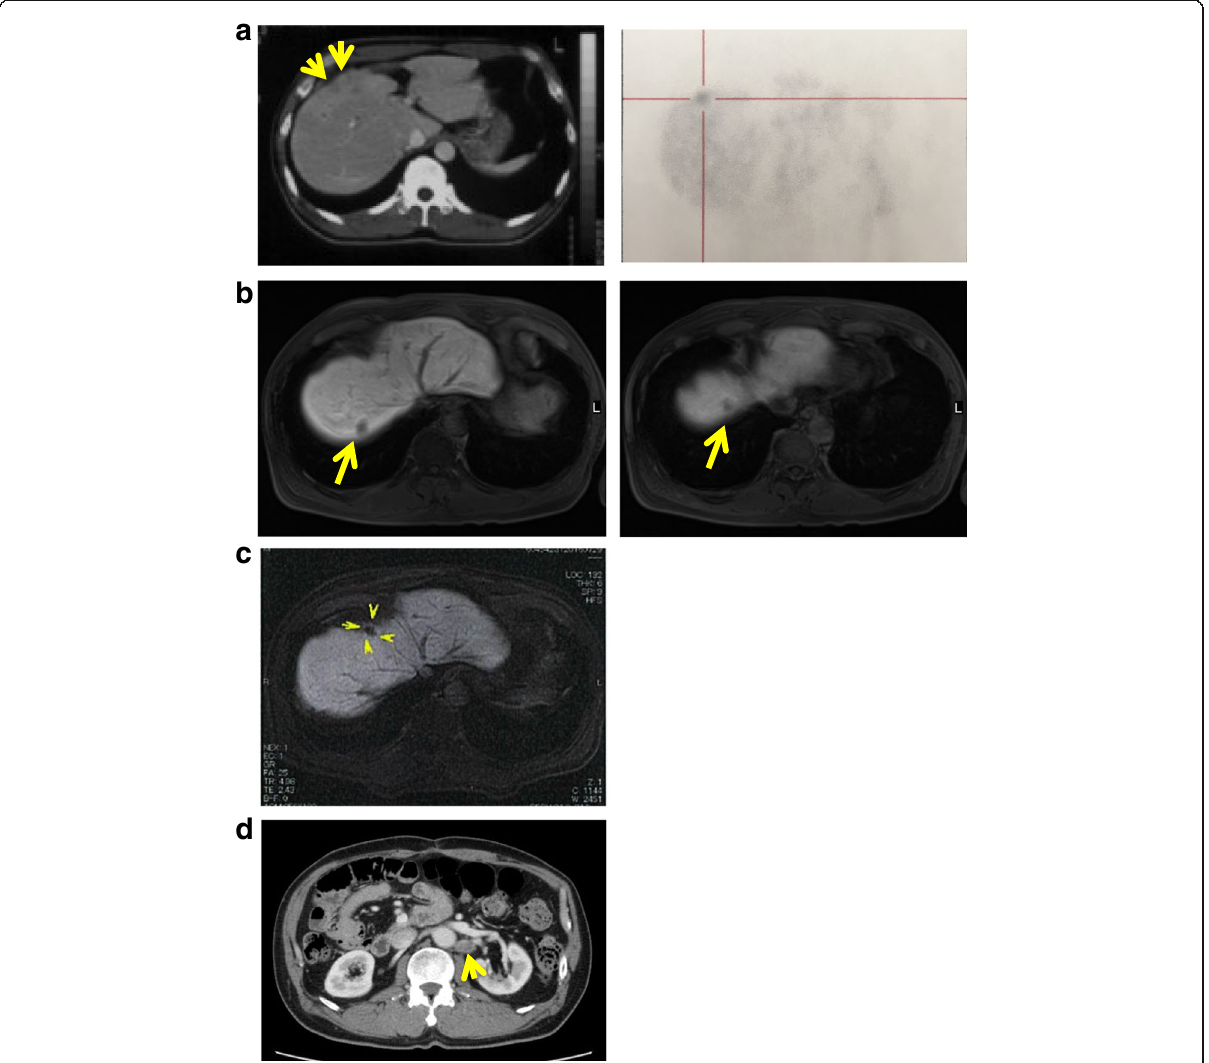
Fig. 3 Image diagnosis. a Left: positron emission tomography-computed tomography (PET-CT) findings at 3 months after surgery shows poor contrast enhancement area in S5 (arrows). Right: abnormal 18 F-fluorodeoxyglucose (FDG) uptake was detected in the same lesion. b Magnetic resonance imaging (MRI) with gadolinium ethoxybenzyl diethylenetriamine penta-acetic acid (Gd-EOB-DTPA) before first microwave coagulo-necrotic therapy (MCN) shows hypointense lesions (arrows) at S7 and S8 in the hepatobiliary phase. c MRI with Gd-EOB-DTPA before second MCN shows hypointense lesions at S4 (arrows) in the hepatobiliary phase. d Current computed tomography image shows undeniable metastasis (arrow) with contrast effect in para-aortic lymph node, but no